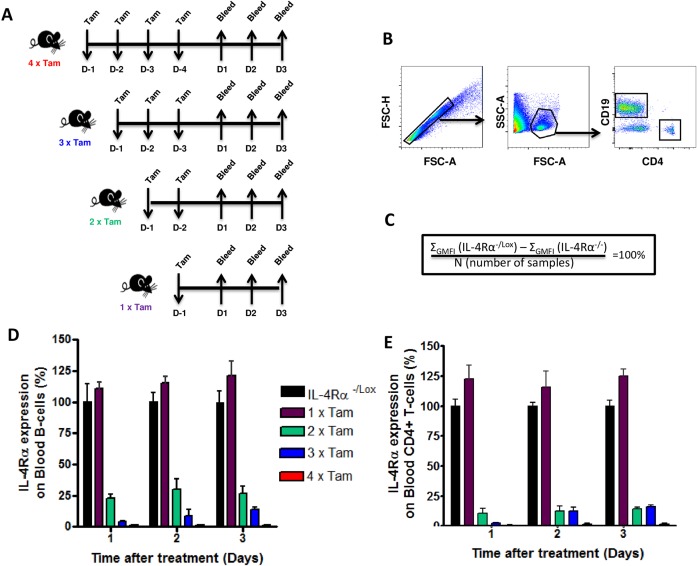
Kinetics of interruption of IL-4Rα expression following tamoxifen administration to iCre-/+IL-4Rα-/Lox mice.A. Experimental design. B. Gating strategy for Blood CD19+CD4- B cells and CD19-CD4+ T-cells. C. Formula for the relative quantification of the levels of IL-4Rα expression on blood B cells. A level of 100% is defined here as the difference between the average IL-4Rα GMFI on cells from control mice (IL-4Rα-/Lox) and that of the average IL-4Rα expression on cells from IL-4Rα deficient mice (IL-4Rα-/-). The relative expression of IL-4Rα of iCre-/+IL-4Rα-/Lox mice fed with tamoxifen as in A is summarized in D for Blood CD19+ B cells and E for Blood CD4+ T-cells. The experiment was conducted with 3–4 mice per group. Data are expressed as mean ± SD.